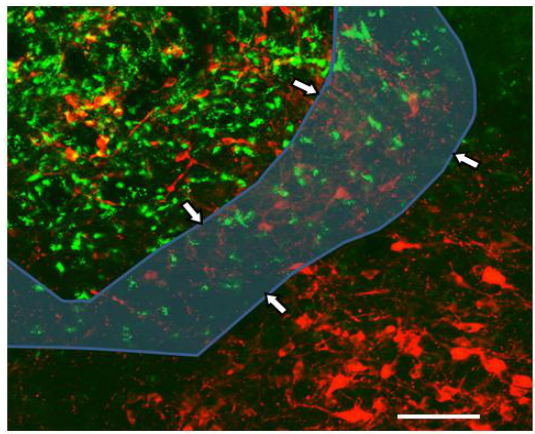
Figure 6. A Neurons are Found in the pNTS. An off-center cross-sectional close-up of rat 2 brain shows red for immunostain for dopamine beta hydroxylase (DbH), a marker for A neurons. Fluorogold™ administered intravenously 15 min prior to sacrifice appears green. The pNTS is the area of blue transparency with arrows at the margins. The AP at upper left and the pNTS exhibit both NE-producing cells and Fluorogold™, but Fluorogold™ does not appear elsewhere in the NTS, lower right. The scale bar is 200 microns. Photo and technical description were provided for original use in this article by Linda